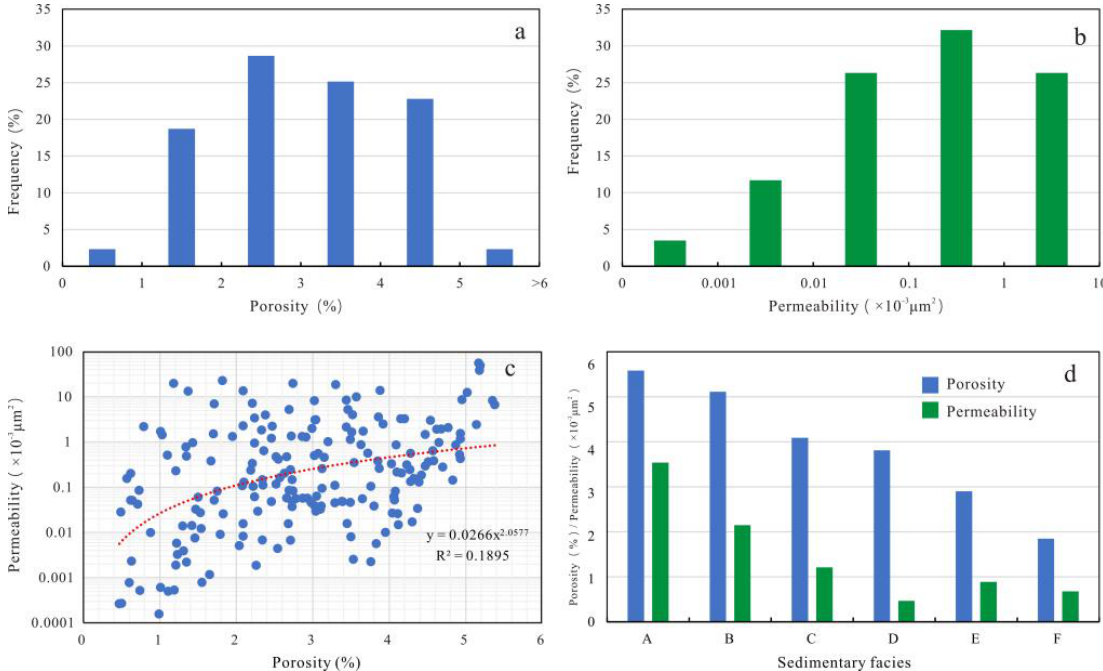
Figure 4. ( a ). Histogram of porosity, S 1 l; ( b ). Histogram of permeability, S 1 l; ( c ). Relations between porosity and permeability, porosity has a weak positive correlation with permeability (red dotted line), correlation coefficient R 2 is 0.1895. S 1 l; ( d ). Distribution histogram of porosity and permeability of various sedimentary